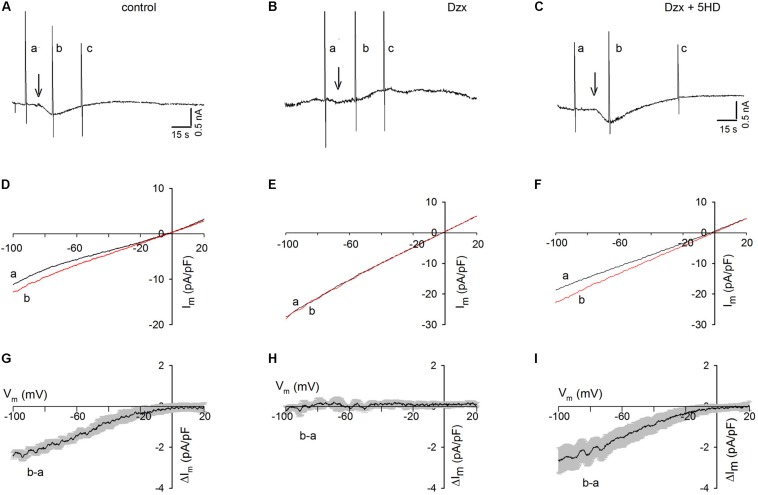
Dzx-induced PPC prevents SOC currents in cardiomyocytes upon application of voltage ramps. Black lines represent I–V curves during ramps before Tg; red lines represent I–V relationships during the first voltage ramp after Tg. (A–C) Continuous recordings of membrane currents under control (A), Dzx pretreatment (B), and Dzx + 5-HD pretreatment (C) conditions. Letters a–c indicate application of voltage ramps. Arrows indicate the addition of Tg. HP = –80 mV. (D–F) I–V curves correspond with the experiments illustrated above in panels (A–C). Notice that the addition of Tg increased membrane currents (D,F), as reflected by separation of the a and b curves, but had no effect when mitoKATP channels were opened by Dzx (E). (G–I) Mean values (±SEM, n = 4–8) of Tg-generated currents b–a as a function of membrane potential from experiments performed exactly as those in panels (D–F).